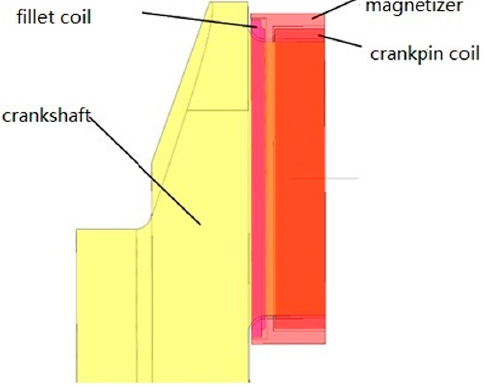
Figure 1. The induction coils and the crankshaft.